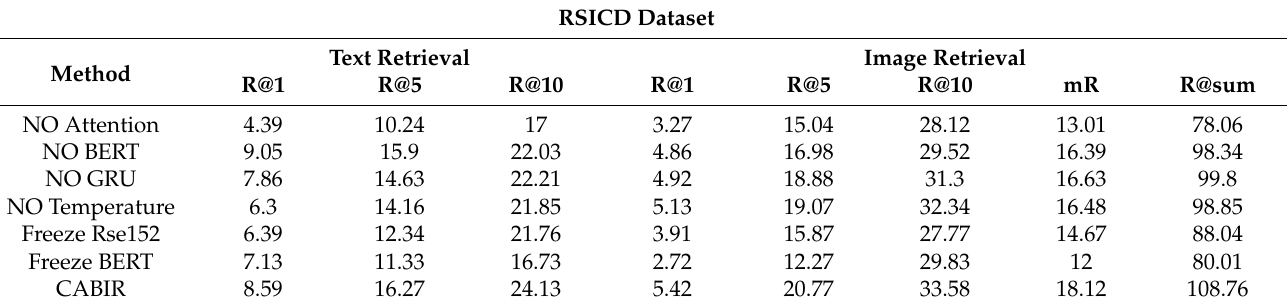
Table 4. Comparison of the results of all variants of CABIR on the RSICD dataset.